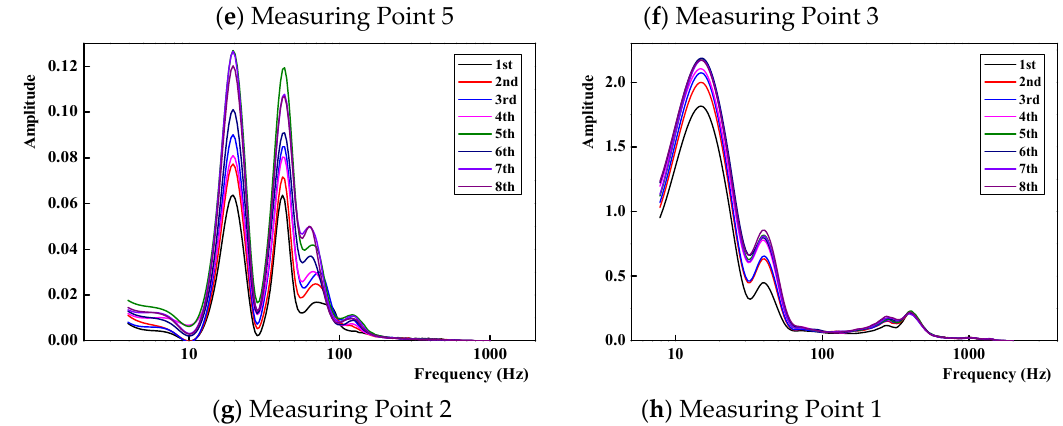
Figure 13. Hilbert marginal spectrum of each measuring point of wheel and filling materials.